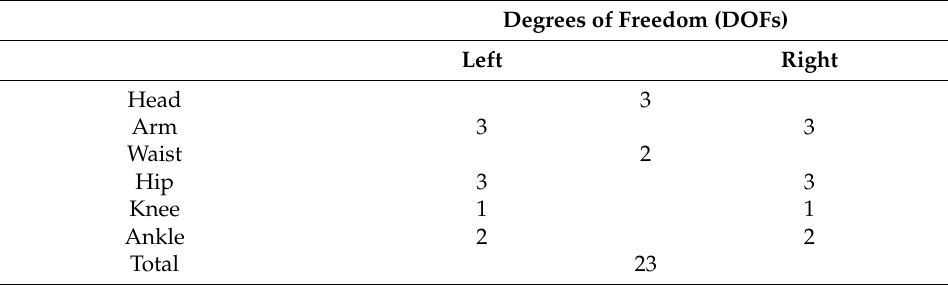
Figure 2. Three-dimensional design of skiing robot DIANA. Table 1. DIANA’s degrees of freedom